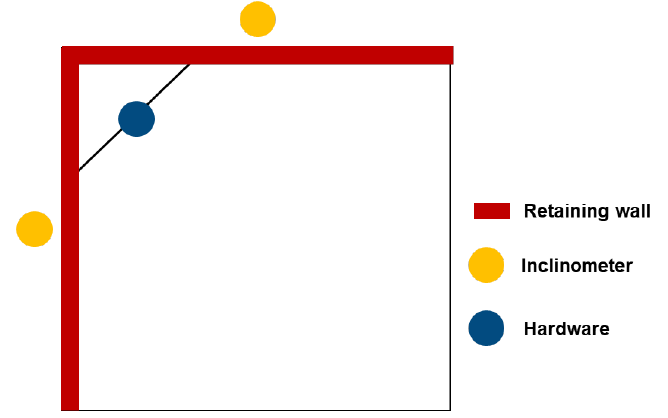
Figure 14. Measurement-site assumptions for LCC analyses. Table 4. Assumed measurement site parameters.